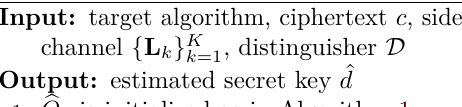
Algorithm 2 Sequential